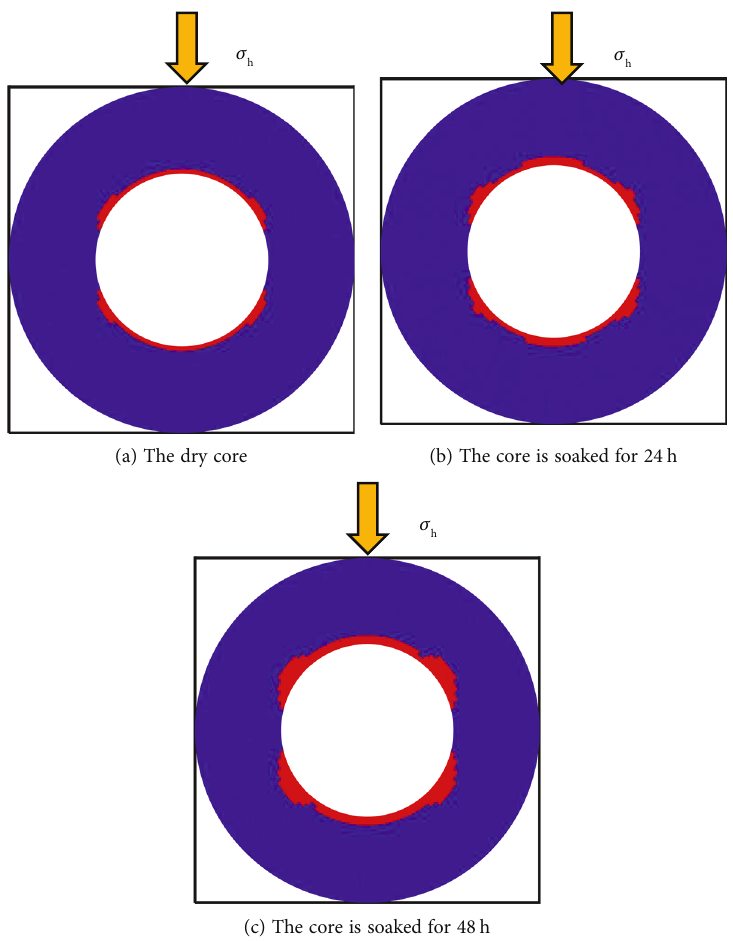
Figure 7: Polar plots of shale gas well collapse pressure under di ff erent moisture contents.